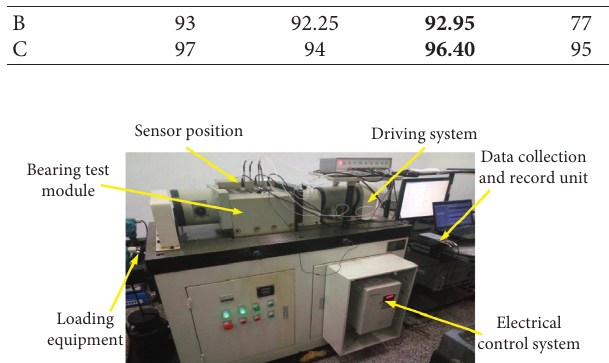
Table 9: Diagnostic results of different methods without LS feature selection for the B dataset and C dataset in case 1. Dataset